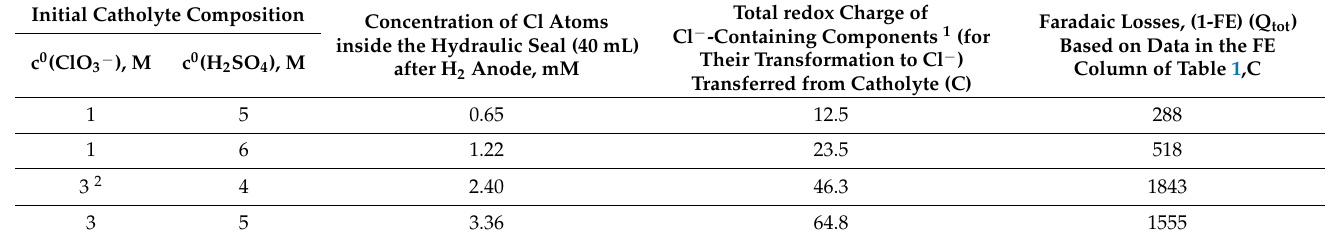
Table 2. Amount of chloride anion inside the hydraulic seal (the technique is described in SM) at the outlet of the anode space of the hydrogen-chlorate cell after the end of each potentiostatic loading experiment at 0.7 V and comparison with the value of the faradaic loss of charge (1-FE) (Q tot ) for the same experiment.